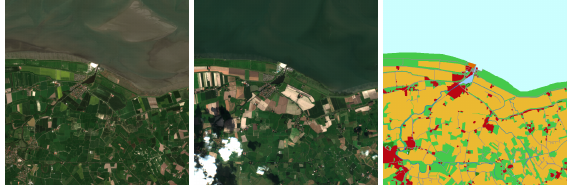
Figure 3. A Sentinel-2 tile of size 8 × 8 km 2 for April 2019 (left), September 2020 (middle), and the corrected reference for 2020 (right). The colours correspond to: red - bld. , grey - sld. , yellow - agr. , light green - grl. , dark green - for. , dark blue - fwt. , light blue - swt , turquoise - sea , brown -